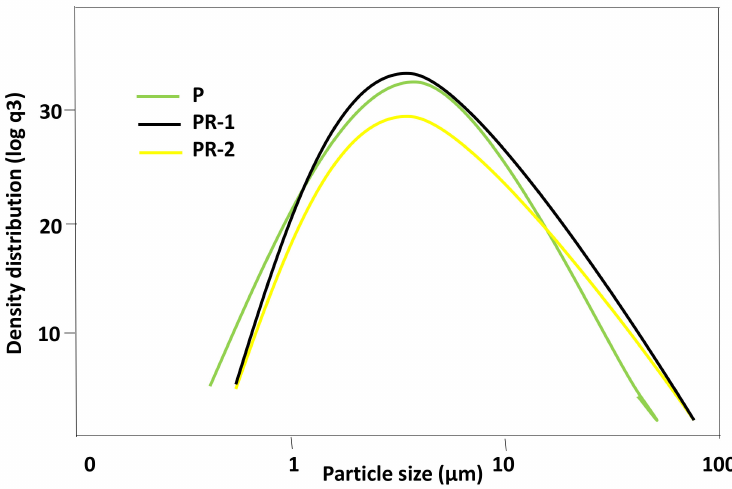
Figure 3. Distribution by particle size from the studied